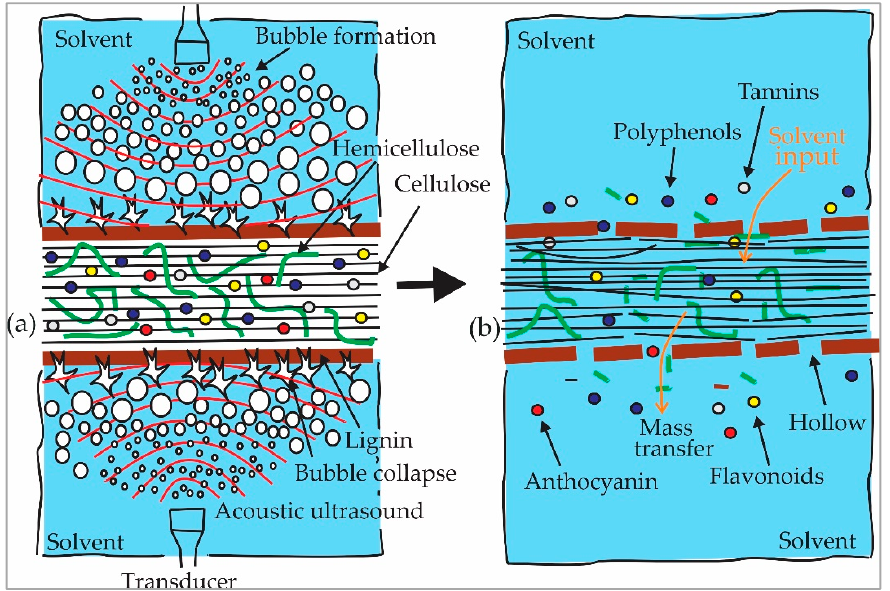
Figure 3. Effect of acoustic cavitation on plant cell wall during the extraction of bioactive compounds by ultrasonic assisted extraction method. ( a ) Cell wall during treatment, ( b ) cell wall after UAE process.